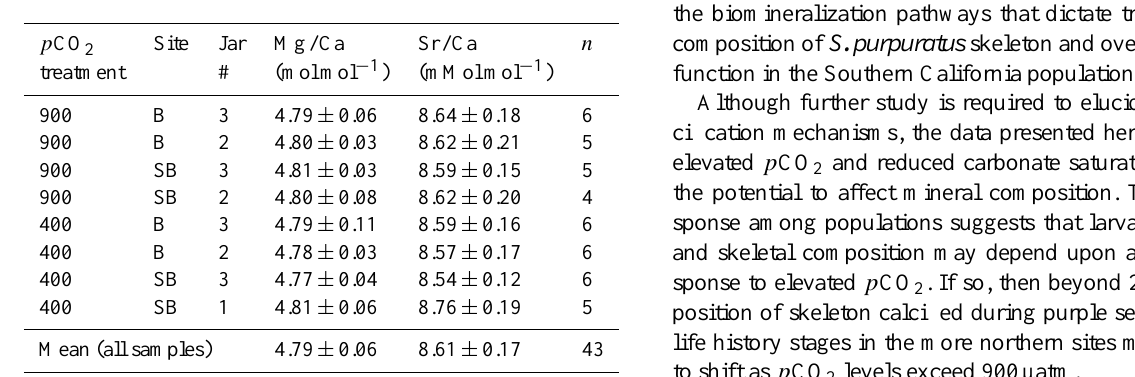
Table 5. Mean ( ± 1SD) trace elemental ratios in culture